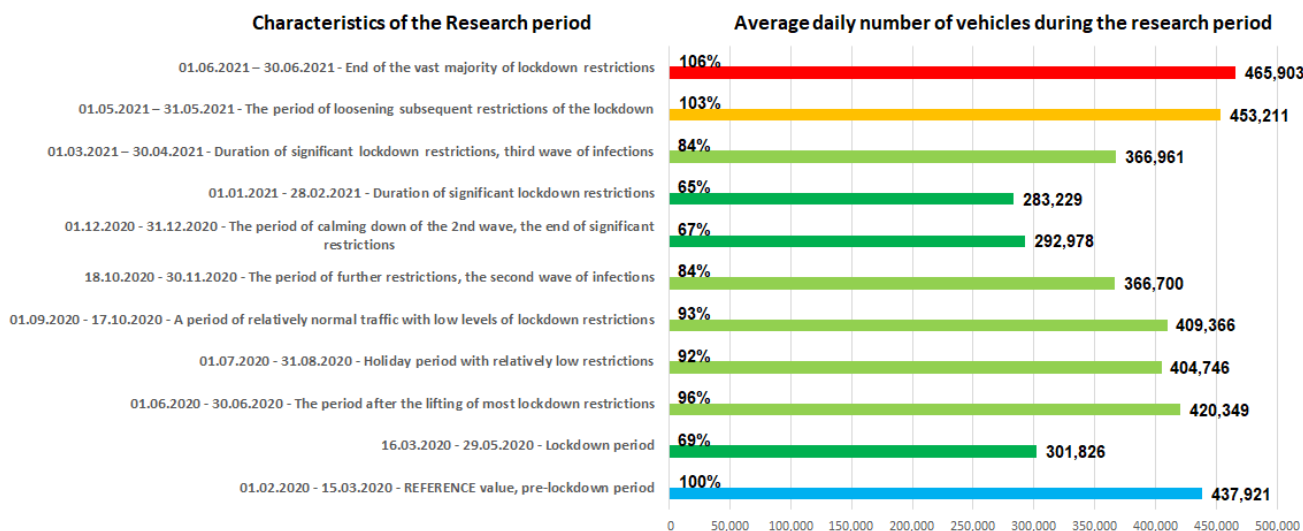
Figure 6. Average daily number of vehicles during the research period. Source: based on [4].